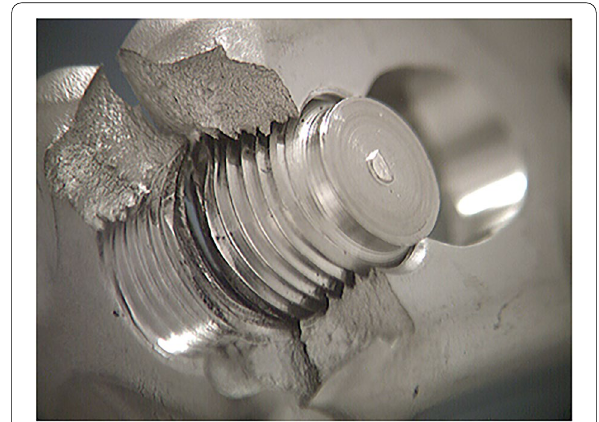
Fig. 3 All plates failed through the threaded portion of a hole adjacent to the loading anvil